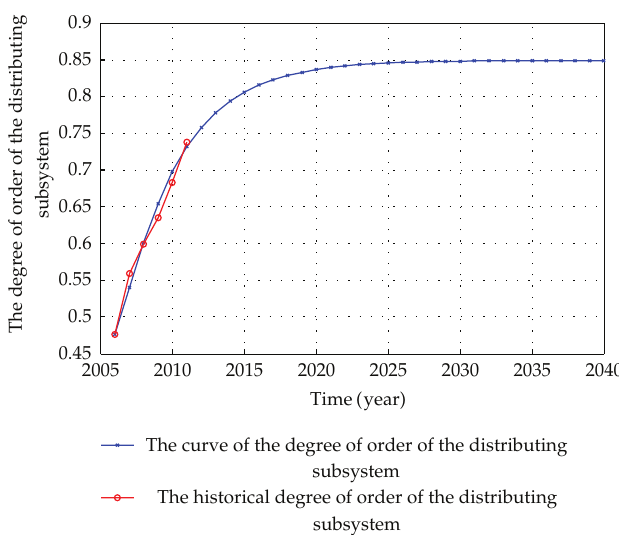
Figure 4: The synergy evolution curve of the degree of order of the distributing